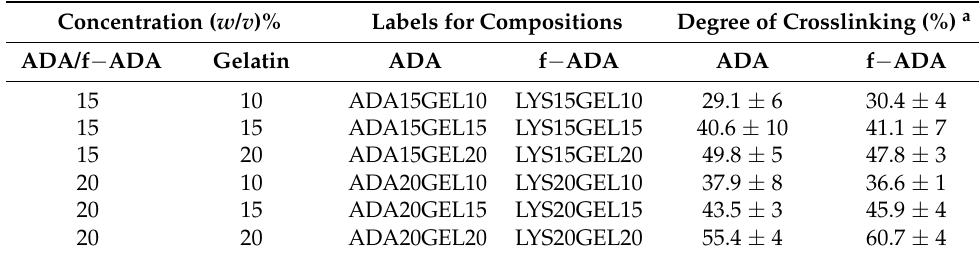
Table 3. Labels are used for the different samples as a function of their composition and crosslinking degree. Concentration ( w / v )% Labels for Compositions Degree of Crosslinking (%) a ADA/f − ADA Gelatin ADA f − ADA ADA f − ADA 15 10 ADA15GEL10 LYS15GEL10 29.1 ± 6